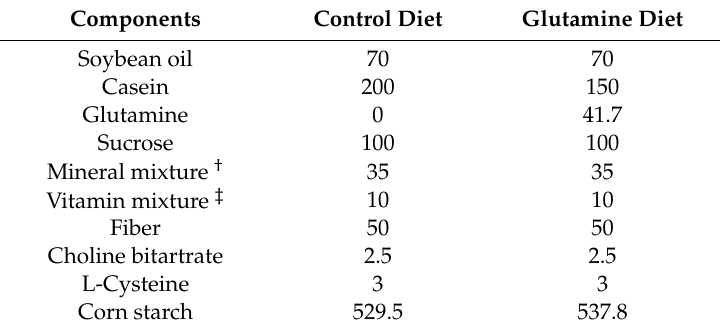
Table 1. Composition of the experimental diets (g / kg). Components Control